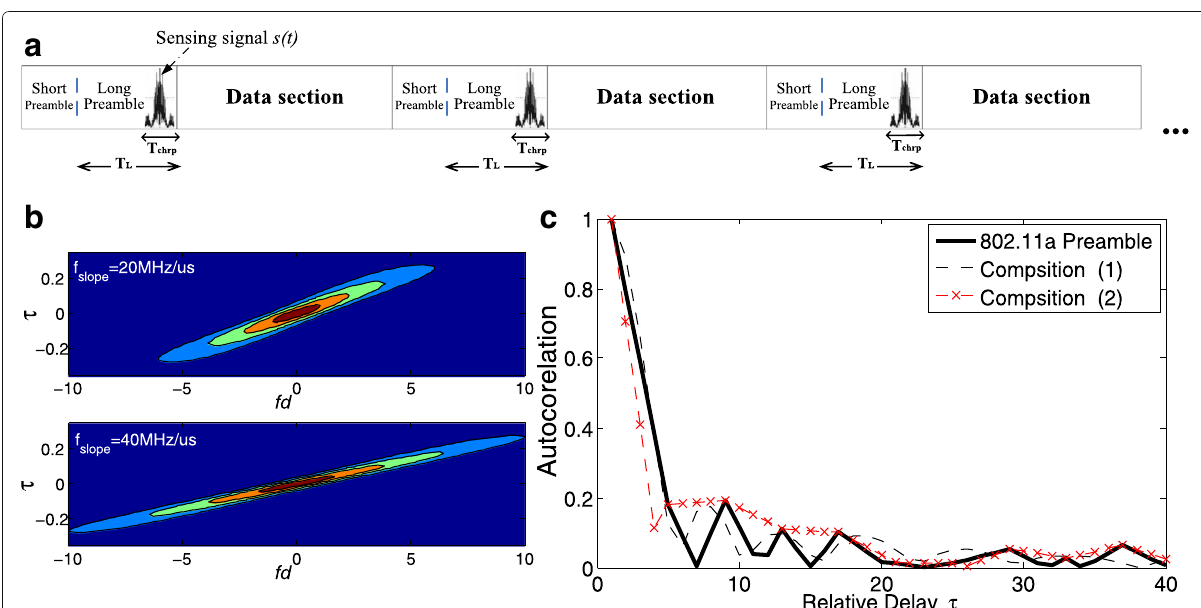
Fig. 1 Signal composition integration. a Overlaying the sensing signal onto WiFi. b Ambiguity function with different f slope . c Autocorrelation of